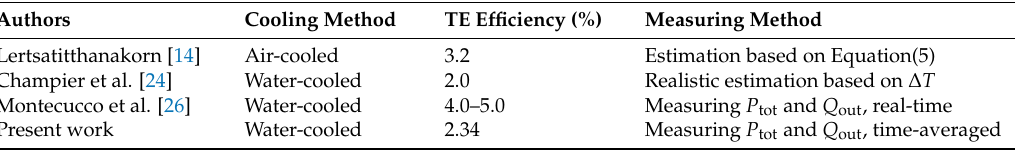
Table 4. Comparison of TE efficiency with previous